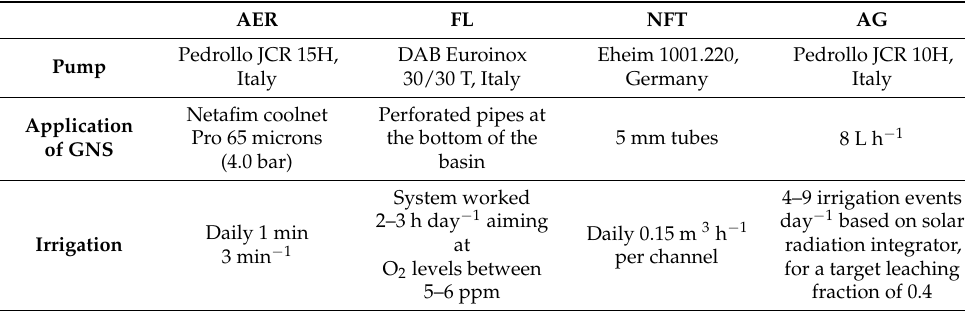
Table 1. Hardware and irrigation management.